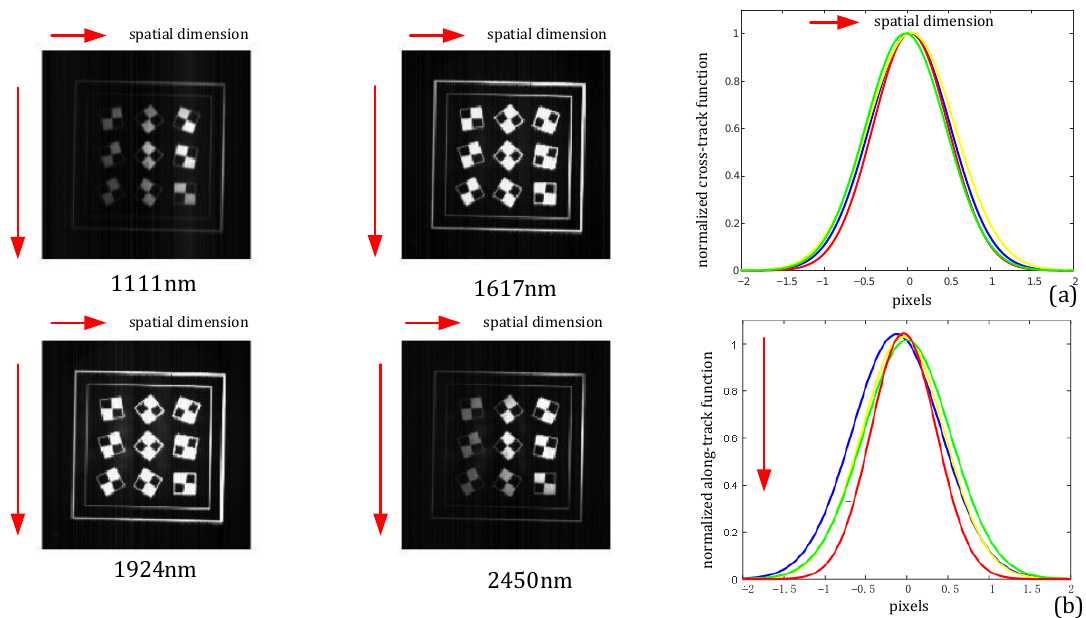
Figure 8. ( a ) Cross-track spatial response functions of spatial pixels for the 1111, 1617, 1924, and 2450 nm wavelengths; ( b ) along-track spatial response functions for the 1111, 1617, 1924, and 2450 nm wavelengths.